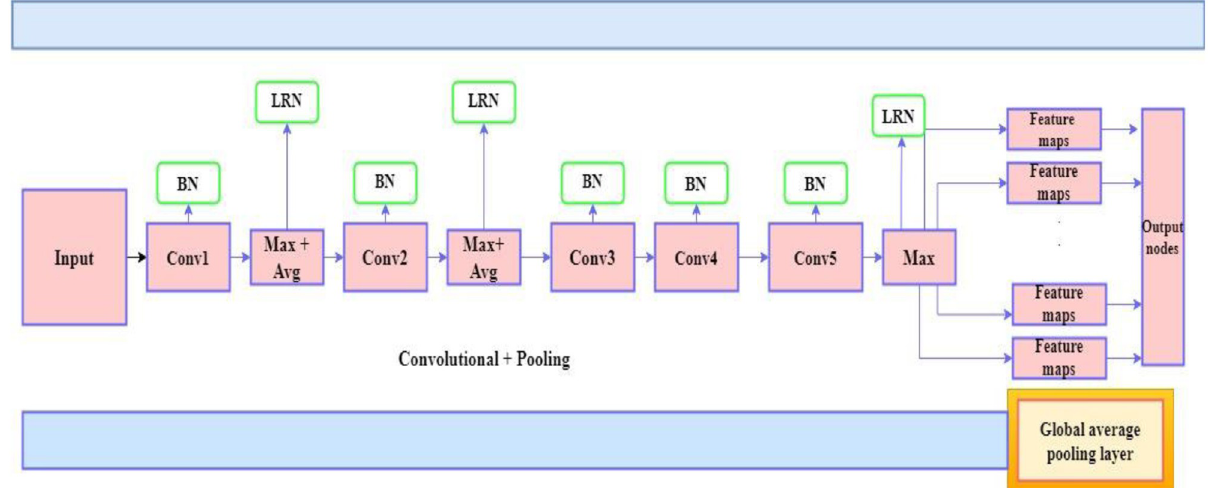
Fig 6. Architecture of the improved AlexNet model.